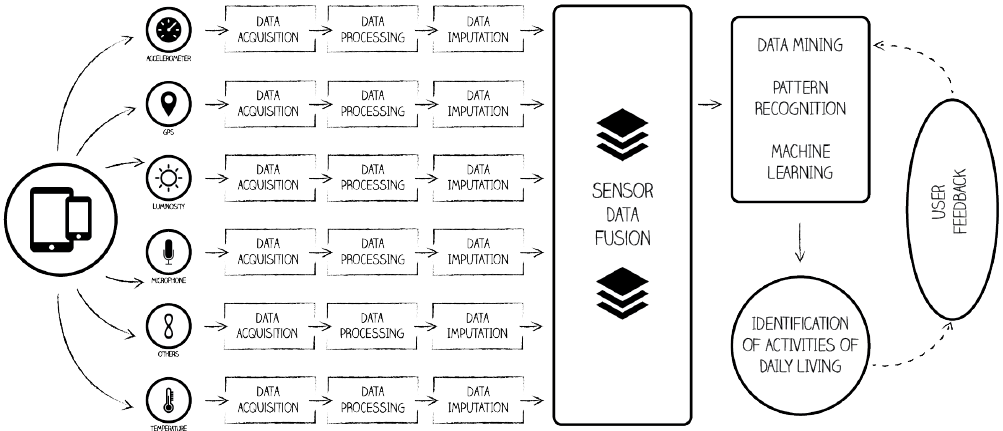
Figure 1. Schema of a multi-sensor mobile system to recognize activities of daily